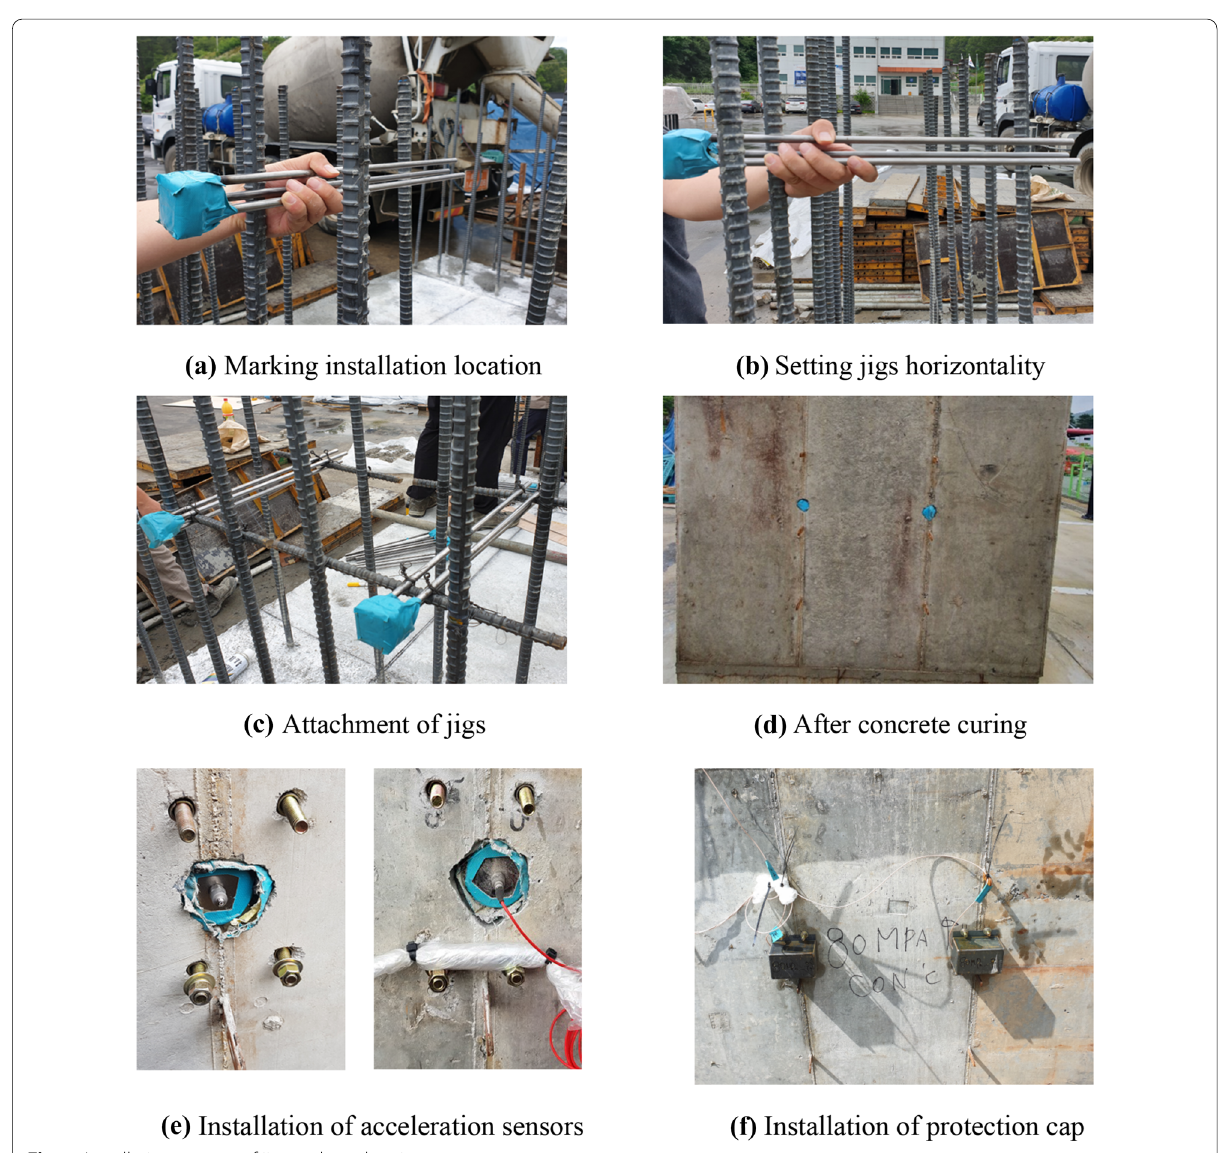
Fig. 5 Installation process of jigs and acceleration